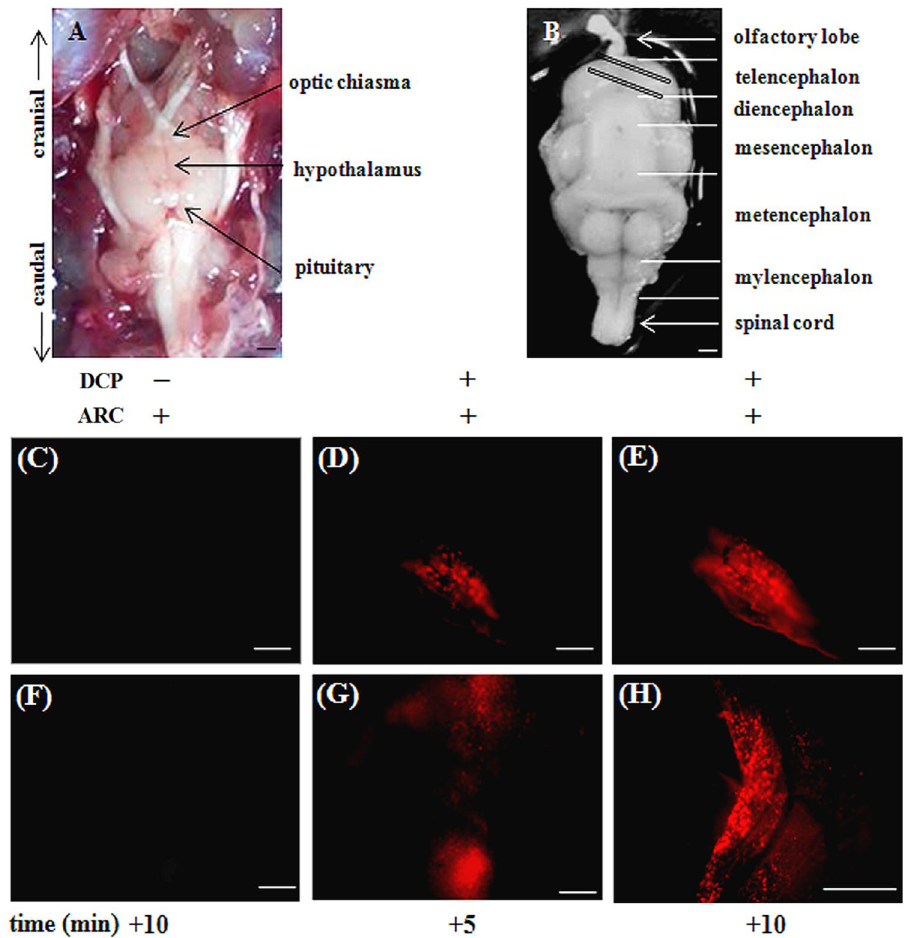
Figure 4. Representative photomicrographs of Catfish brain (ventral side up) showing cranial and caudal ends, hypothalamus, pituitary and optic chiasma during dissection ( A ) and after harvesting in chilled PBS ( B ). Brain slices from telencephalon (marked as diagonal rectangles in ( B ) were pre-incubated with ARC , washed with PBS, treated with the analyte DCP , washed again to remove excess DCP and observed under fluorescence inverted microscope at 5 min intervals ( D , E from upper slice and G , H from lower slice). Parallel slices treated with ARC only served as negative control ( C , F ). Figures are representative of three independent observations from separate donors, scale bar ~1 mm ( A , B ); ~200 µ m from ( C to G ) and ~400 µ m for ( H ).